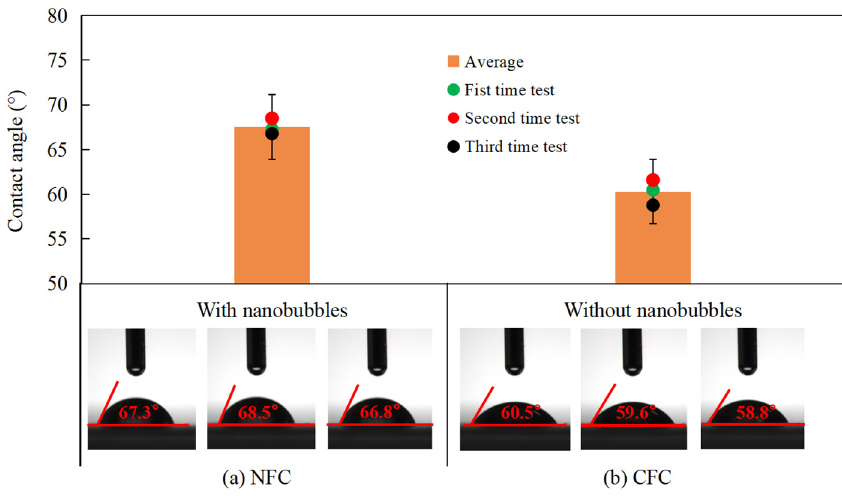
Figure 13. Contact angle measurements of NFC ( a ) and CFC ( b ).